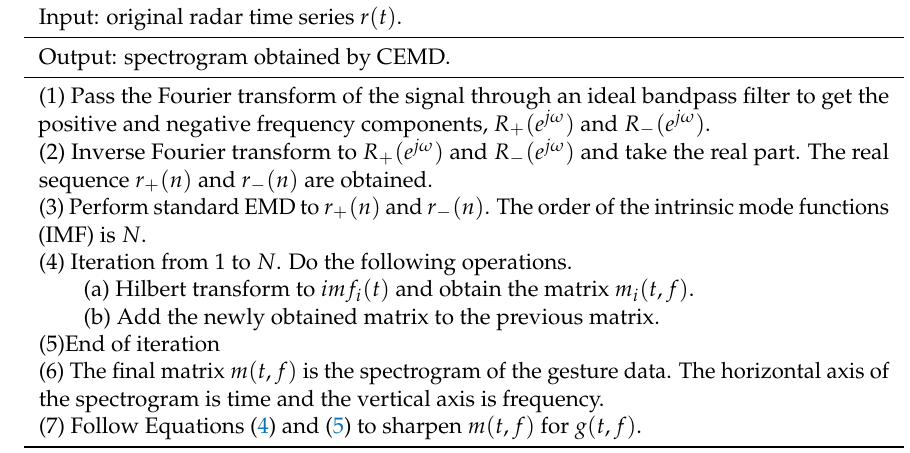
Table 1. CEMD-based time-frequency analysis